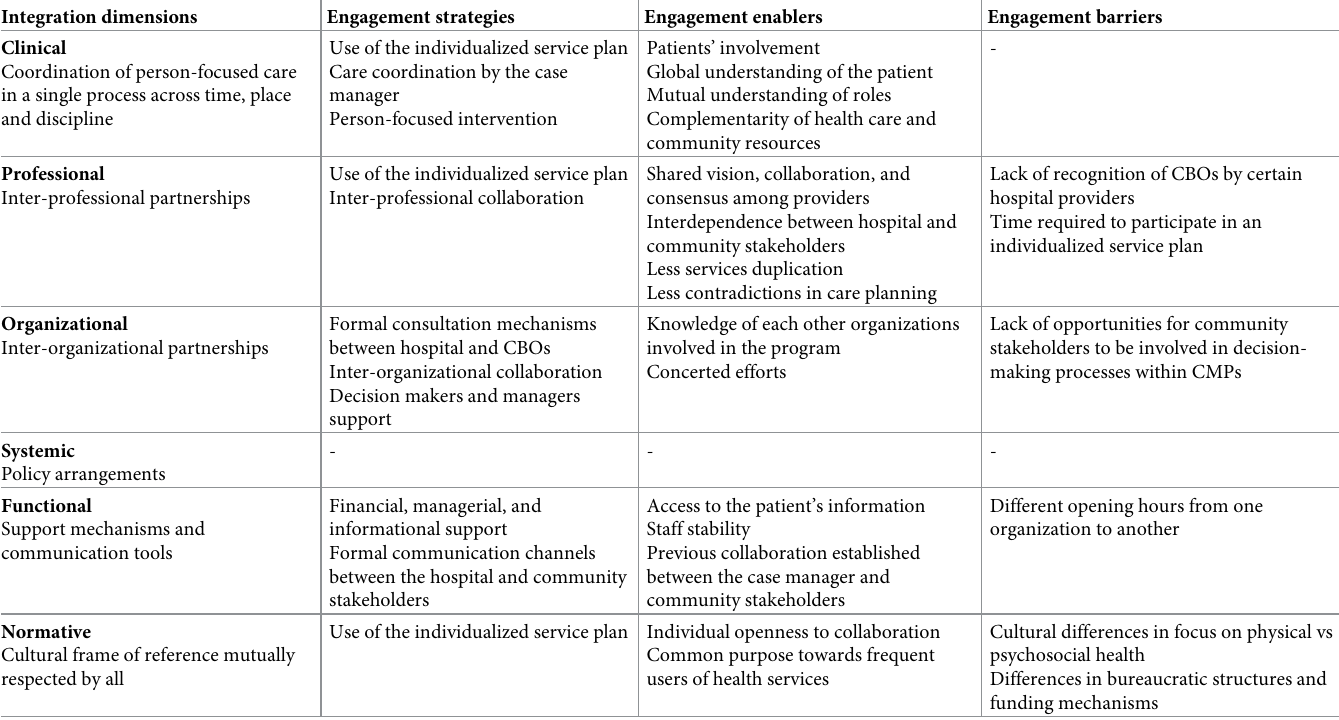
Table 2. Strategies, enablers, and barriers for community stakeholders’ engagement in CMPs according to the Rainbow Model of Integrated Care. Integration